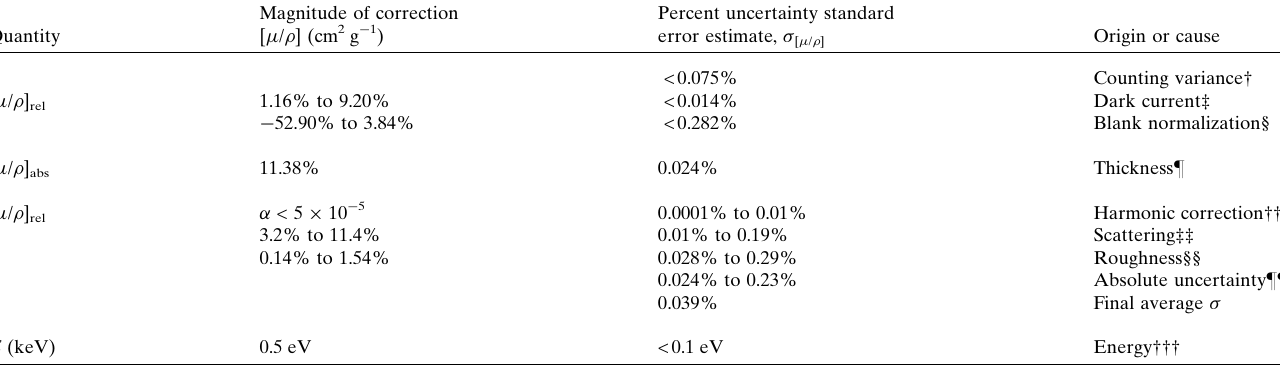
Table 2 Contributions to the overall uncertainty from each source. Corrections are labelled ½ (cid:3)=(cid:2) (cid:2) if they contribute to the shape of the spectra with an independent contribution to uncertainty at each point. ½ (cid:3)=(cid:2) (cid:2) rel corrections that relate to broad scale corrections such as the material thickness. The table gives the maximum individual uncertainty and the average contribution (cid:4) . Extra sources of systematic and uncertainty arising from bandwidth and nanoroughness cannot be measured with a single foil in the current setup.